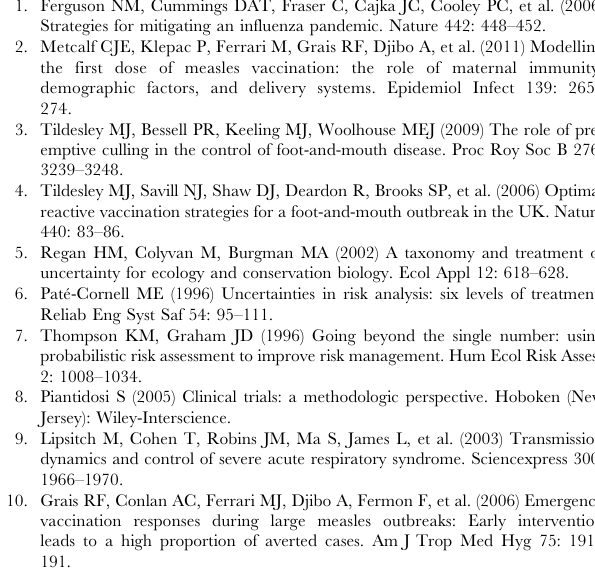
Figure S1 The probability of epidemic outcomes below a stated threshold for four alternative management tactics. Left panels give outcomes for the management objective to minimize total epidemic cost due to livestock loss, the right panels give outcomes for the management objective to minimize the duration of management activities. The x-axis indicates the cost (in millions of £ ) or duration (days) threshold that managers would like to stay below. The y-axis indicates the probability, averaged across all three kernel models, of outcomes below the threshold for each management tactic (solid lines). Panels from top to bottom indicate increasing weight on the 2001 UK kernel, with equal remaining weight on kernels 1 and 3. Figure S2 Ternary plots of the optimal static strategies assuming different utility functions. The top row indicates the optimal static strategy for the objective of minimizing total outbreak cost due to livestock loss. The bottom row indicates the optimal static strategy for the objective of minimizing outbreak duration. Each ternary figure indicates the optimal static culling alternative (colors) for different weightings on the three kernel models (see Figure 3 in the main text for description of ternary plots). Panels from right to left indicate utility functions (insets) that are increasingly risk-seeking. Figure S3 Ternary plots of the optimal static strategies assuming different utility functions. The top row indicates